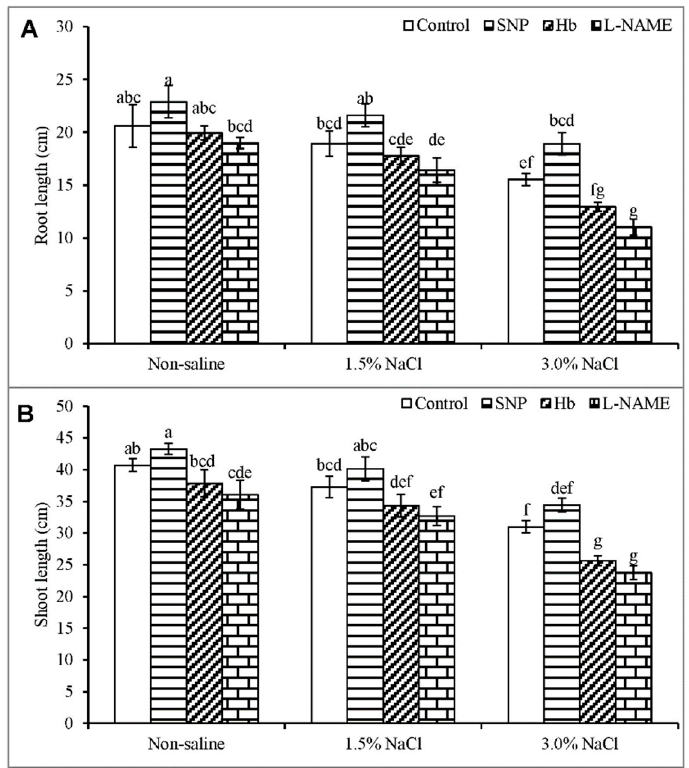
Figure 1. Root length ( A ) and shoot length ( B ) of Kandelia obovata treated with different salt con- centrations and with 100 µM sodium nitroprusside (SNP, a NO donor), hemoglobin (Hb, a NO scavenger), or N ω -nitro- L -arginine methyl ester ( L -NAME, a NO synthase inhibitor). Mean (± SD) was calculated from three replicates for each treatment. Bars with different letters are significantly different at p ≤ 0.05, applying Tukey’s HSD test.